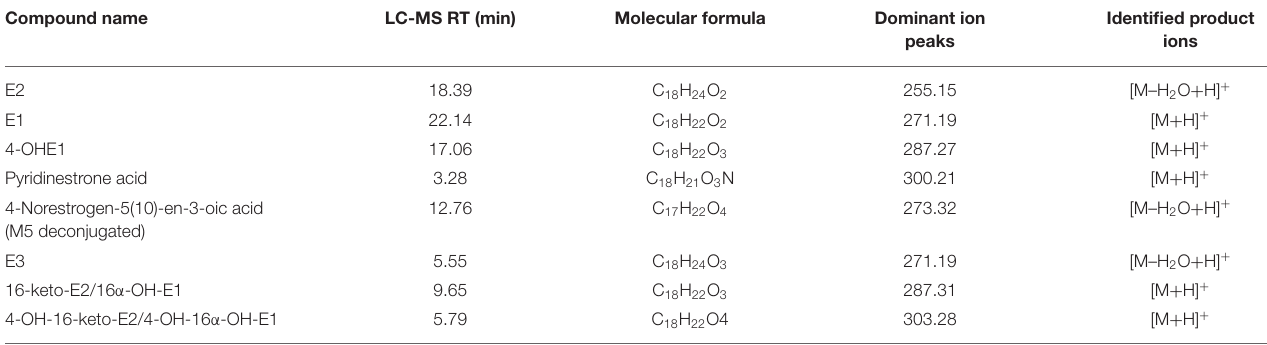
TABLE 2 | LC-MS analysis of metabolites involved in estrogen catabolism in N. tardaugens